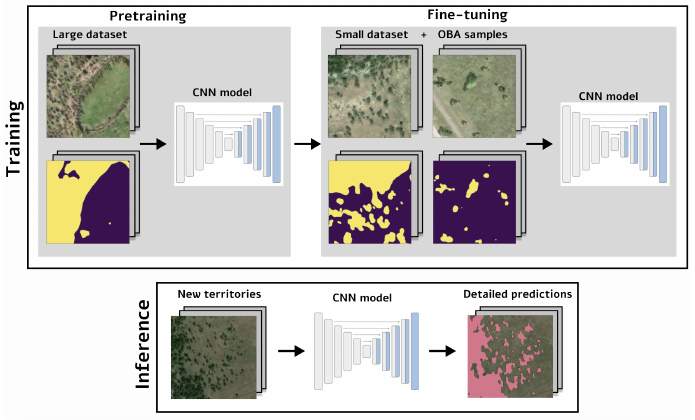
Figure 1. Proposed pipeline for CNN model